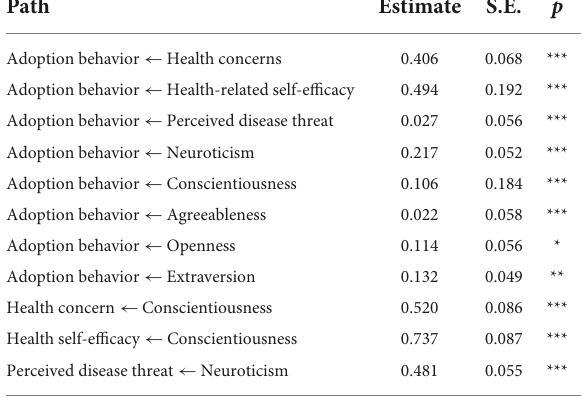
TABLE 6 Standardized path coefficients and results of the hypothesis